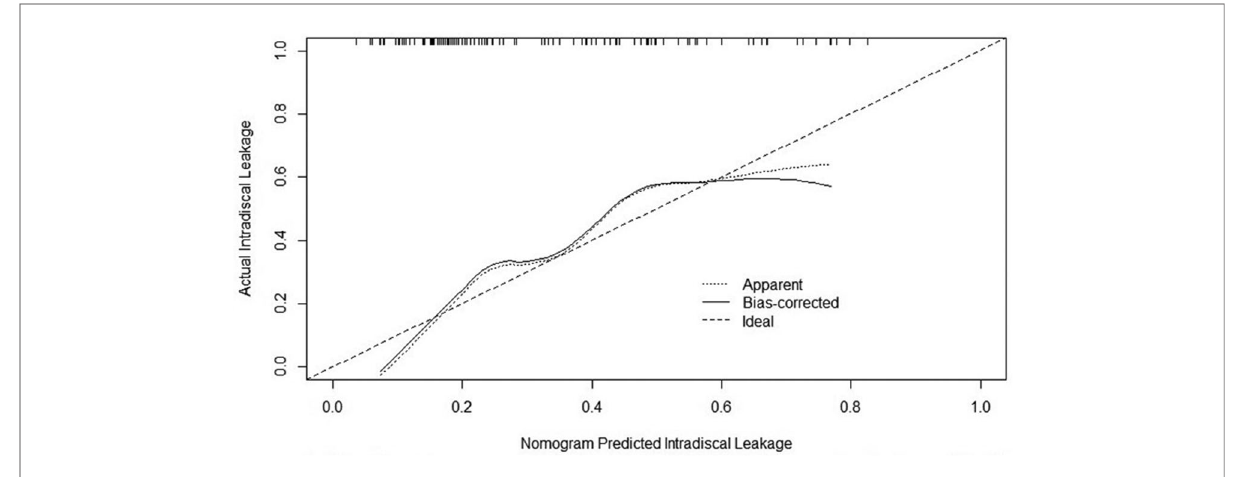
FIGURE 4 Calibration curve of the nomogram showed a well-calibrated predictive model, Hosmer – Lemeshow goodness-of- fi t test P